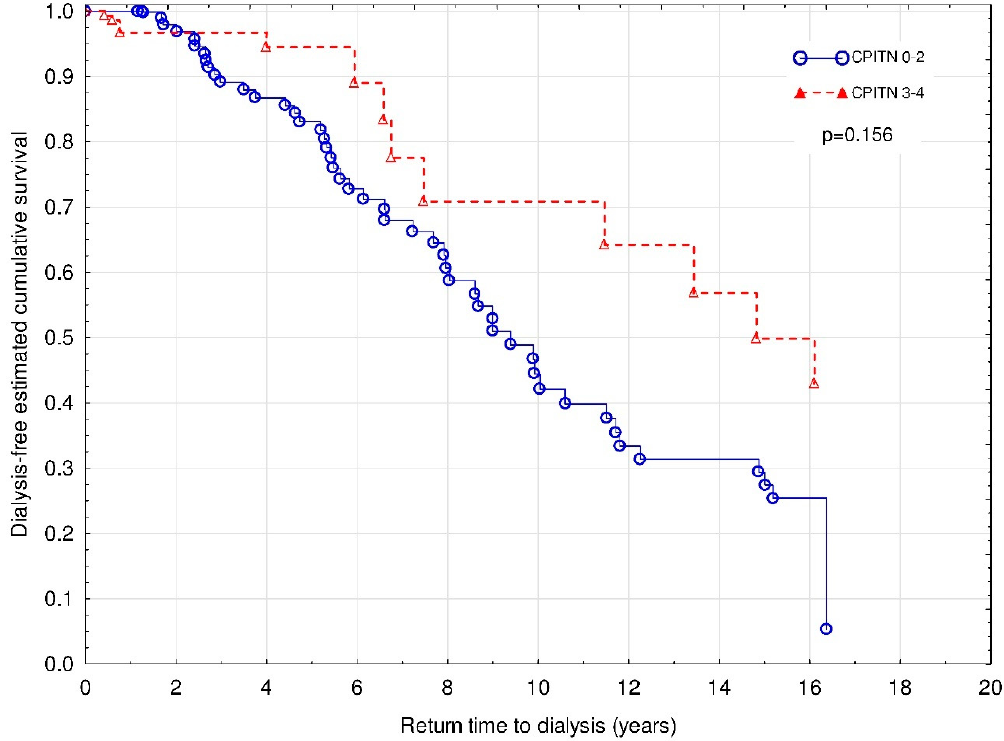
Figure 5. Time to return to hemodialysis for patients with CPITN (0–2) and CPITN (3–4). Covariates: initial serum creatinine, HLA class II mismatch, smoking status, and diastolic BP. initial serum creatinine, HLA class II mismatch, smoking status, and diastolic